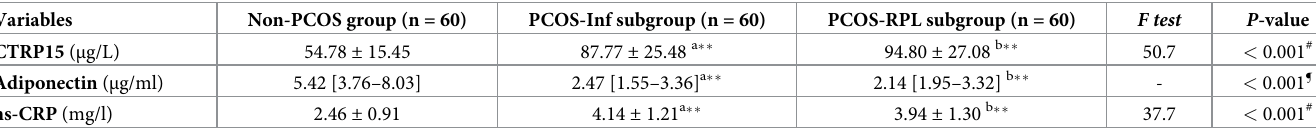
Next, the circulating levels of CTRP15 were stratified according to BMI as normal-weight (BMI � 25 Kg/m 2 ) and overweight/obese (BMI > 25 Kg/m 2 ) (Fig 1). Results indicated that CTRP15 levels were significantly higher in normal-weight and overweight/obese PCOS women (89.69 ± 24.42 and 99.40 ± 25.13 ng/ml, respectively) when compared to normal- weight controls (49.18 ± 14.03 ng/ml, P < 0.01). Furthermore, CTRP15 levels were signifi- cantly elevated–with the greatest magnitude–in overweight/obese PCOS women as opposed to normal-weight PCOS women and overweight/obese non-PCOS women (59.36 ± 15.25 ng/ml, P < 0.01). However, there was no significant difference in circulating levels of CTRP15 between normal-weight and overweight/obese participants in the control group.